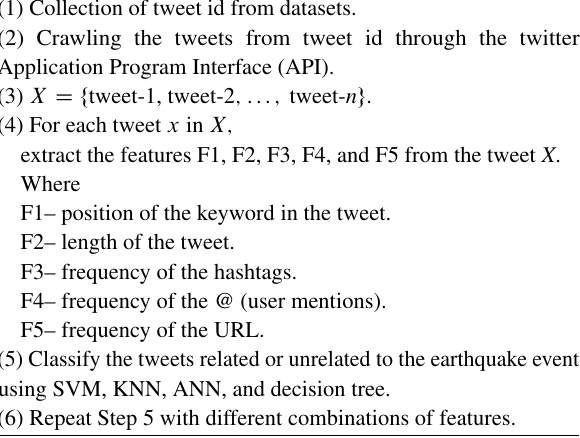
Algorithm 1 Proposed algorithm for target event detection